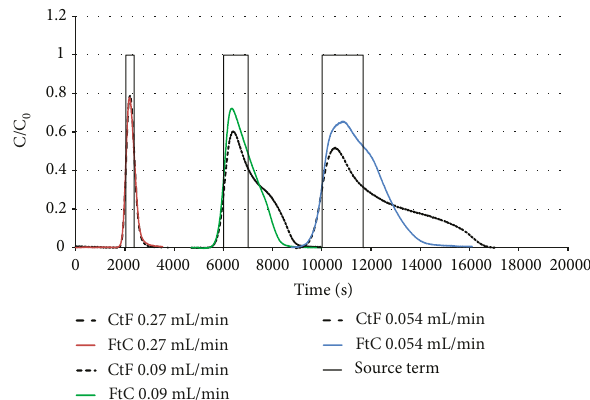
Figure 6: Breakthrough curves for the CtF and FtC experiments with column #2 (F and CC bead sets), for an injection of 1.5 mL of 0.1M solution of sodium nitrate.